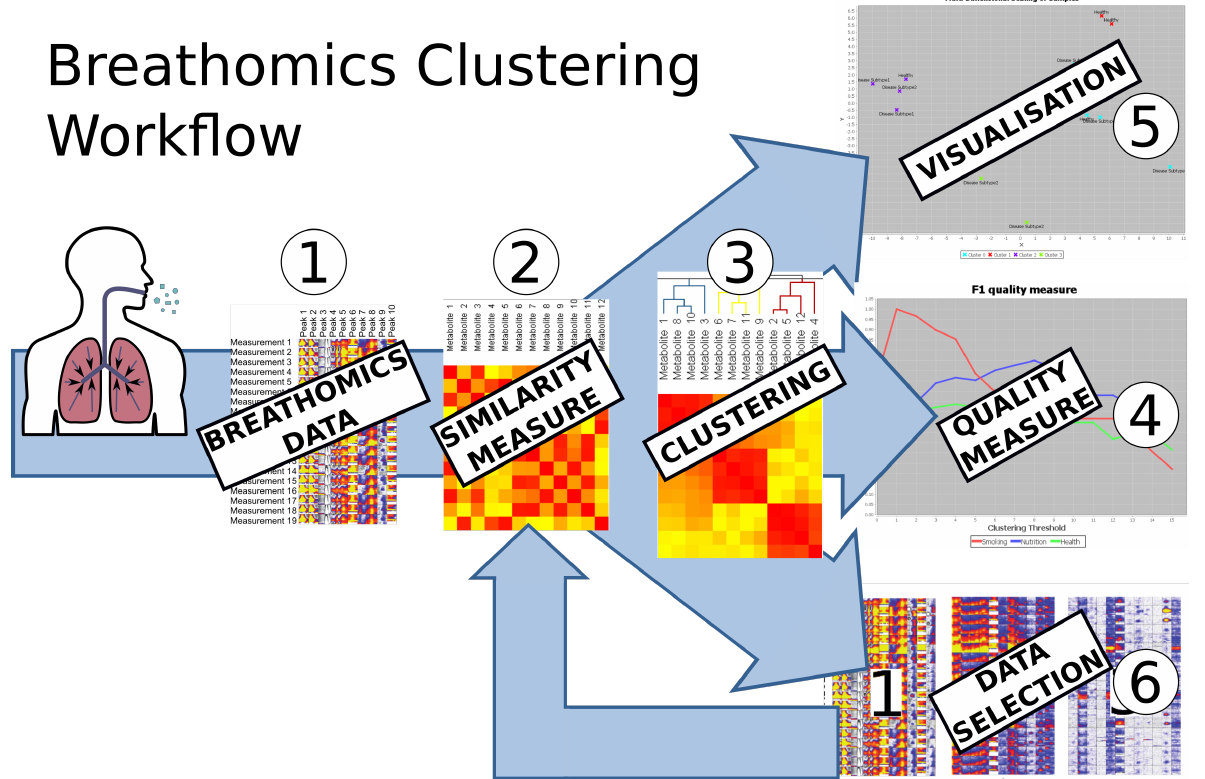
Figure 1. The carotta pipeline consists of several steps: (1) import of pre-processed data (see Section 2); (2) similarity calculation; (3) clustering; (4) clustering quality; (5) similarity or clustering visualization; (6) subset selection. Intermediate results of Steps 2–4 can be inspected, optimized and repeated at an arbitrary